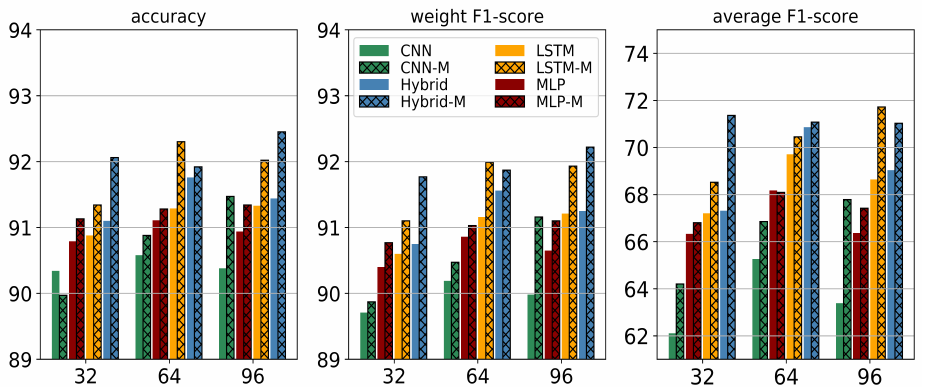
Figure 5. Classification performance results (in percent) using different sliding window lengths on the OPPORTUNITY dataset.